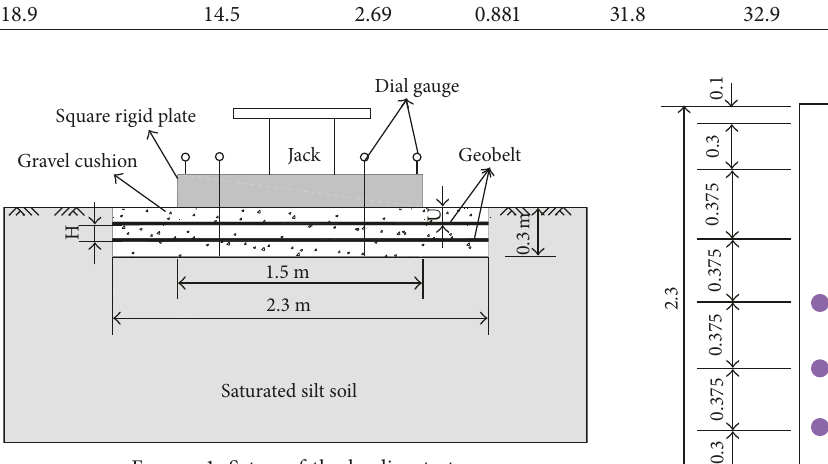
Figure 1: Setup of the loading test.